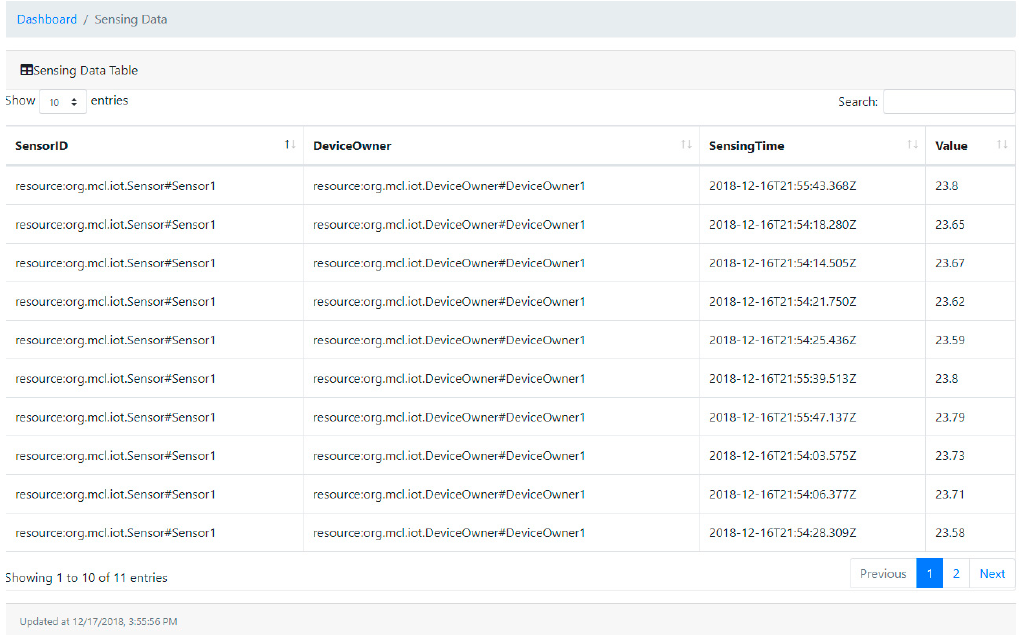
Figure 14. Snapshot of the sensing log dashboard.